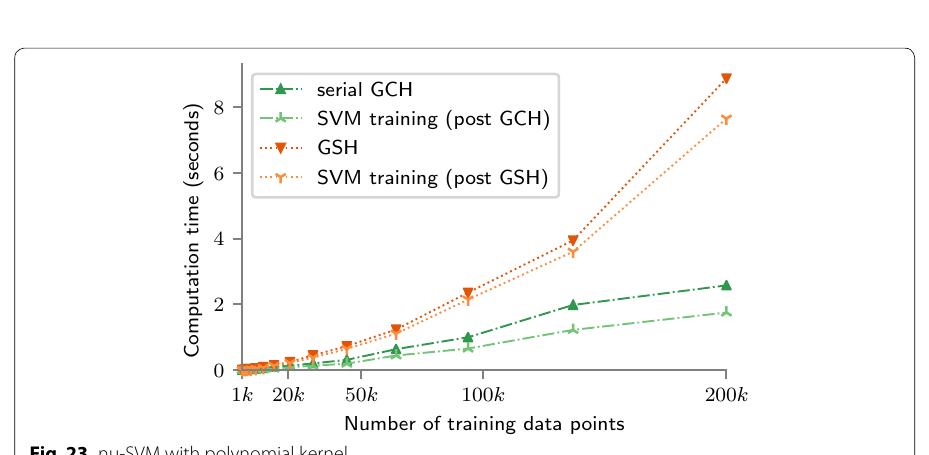
Fig. 22 C-SVM with polynomial kernel